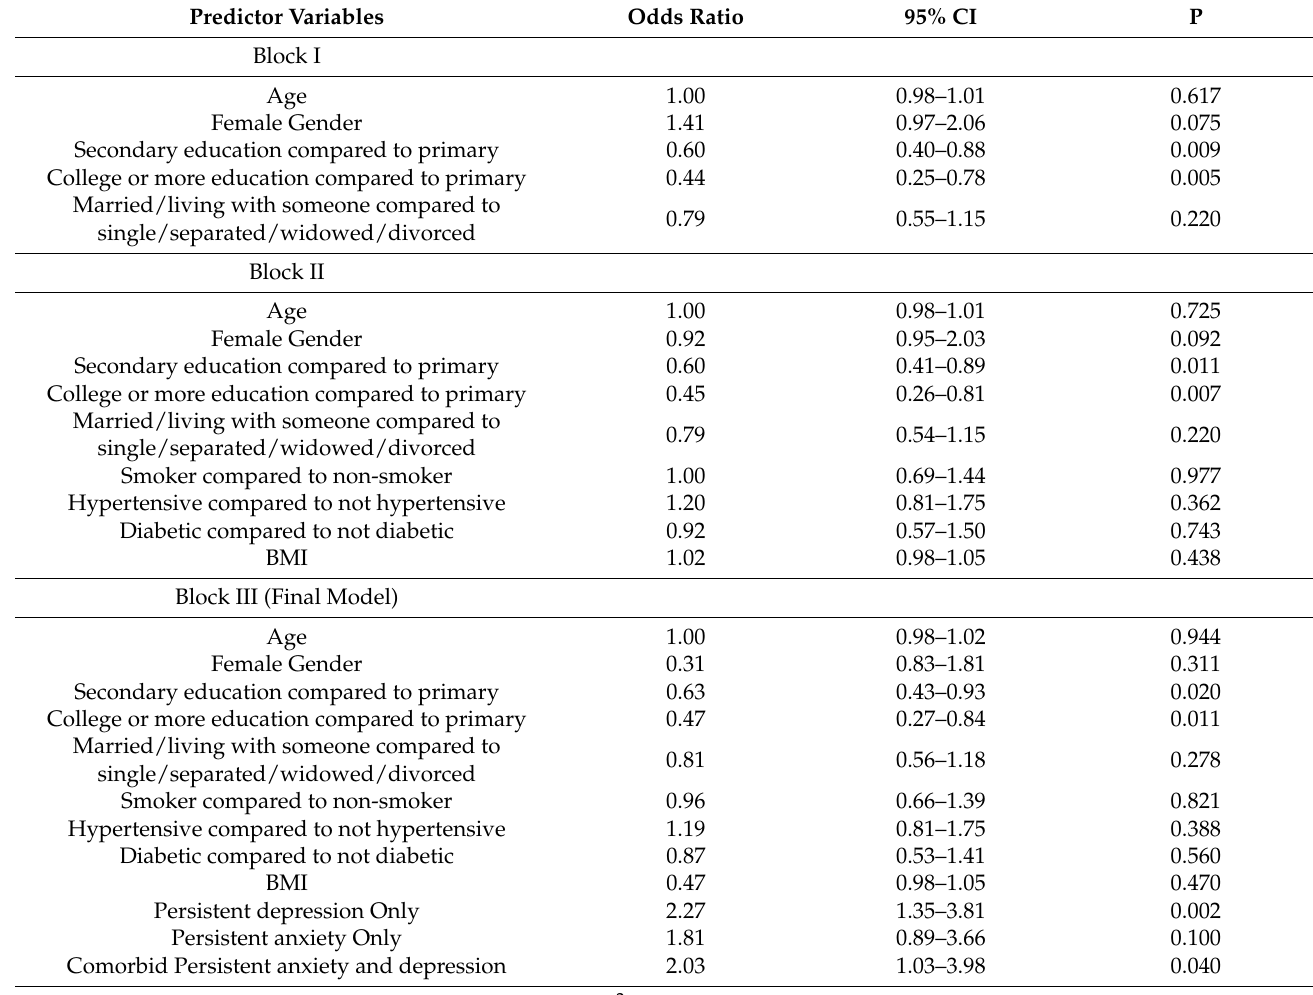
Table 2. Cox proportional hazard regression of variables associated with ACS second event, and anxiety and depression treated as categorical variables.